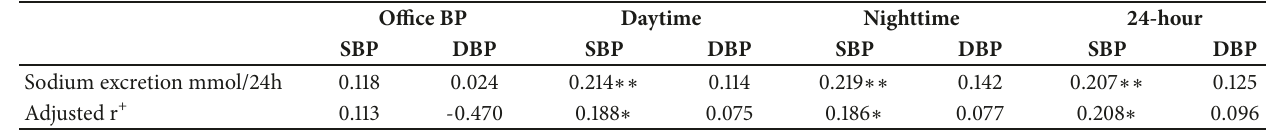
Table 2: Correlation of sodium excretion with office and ambulatory blood pressurecomponents.Without and after adjustment for age, BMI, and